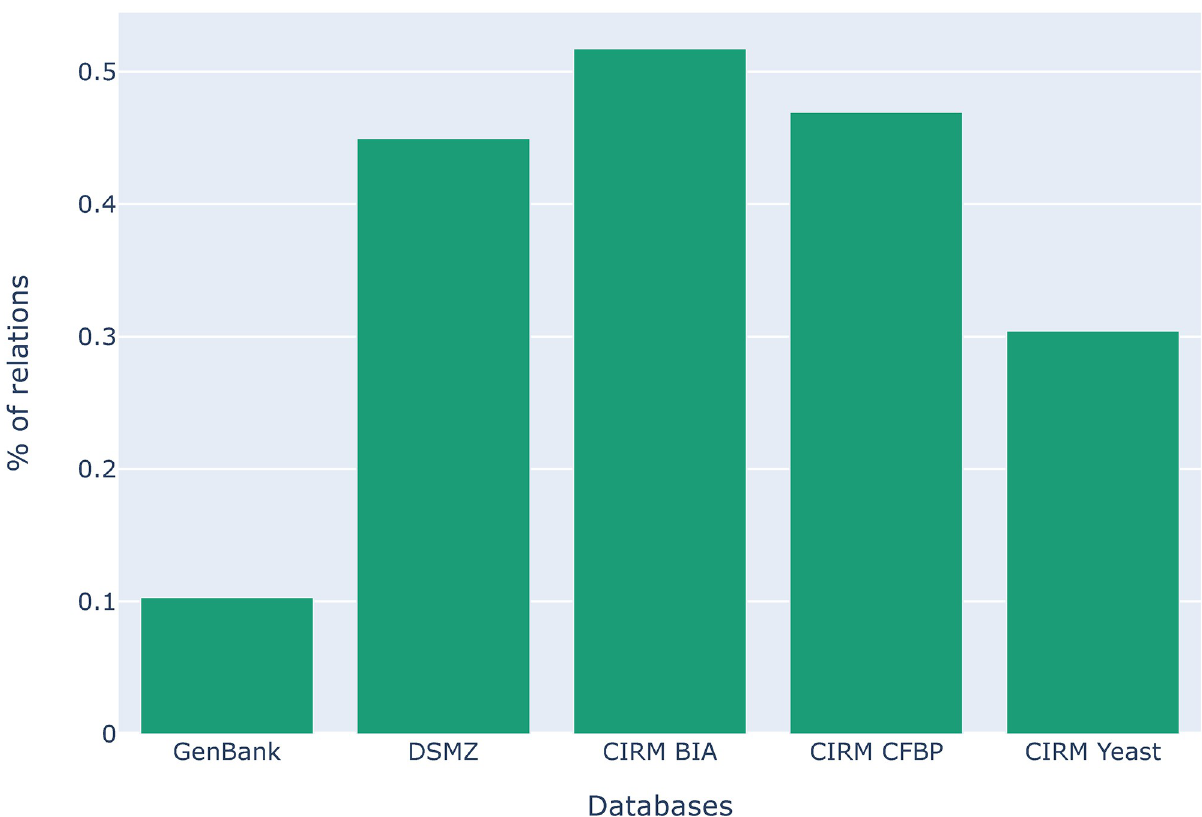
Fig 7. Proportion of taxa-habitat relations in each source, which are also extracted from PubMed. The height of the bar represents the proportion of relations per source that were also extracted from PubMed. For instance, only 10% of relations in GenBank were also extracted from PubMed (the same taxon-habitat pair), leaving 90% of relations exclusive to GenBank.